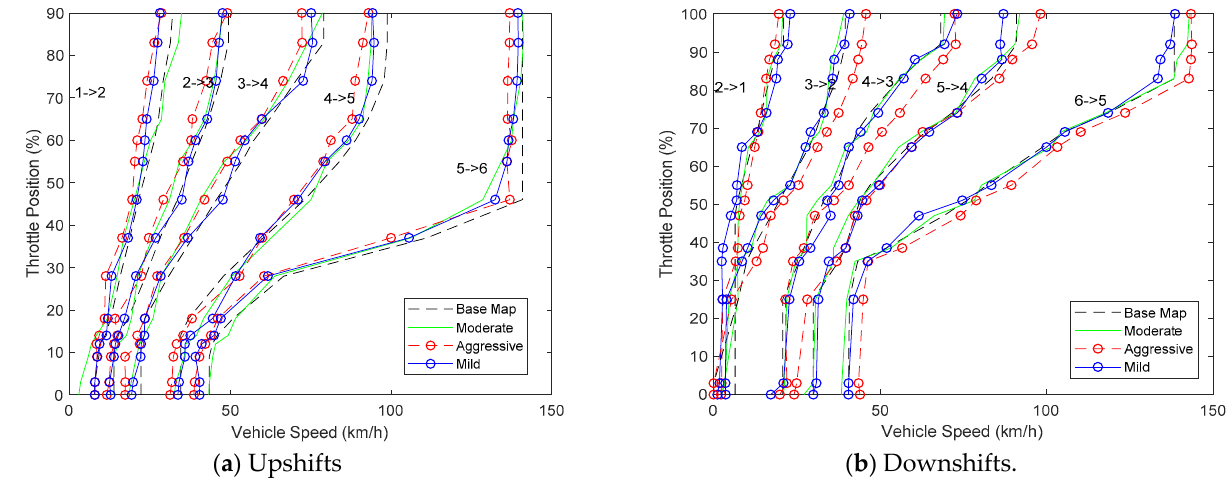
Figure 12. Example of calibrated shift-schedules for different styled drivers compared with base map.